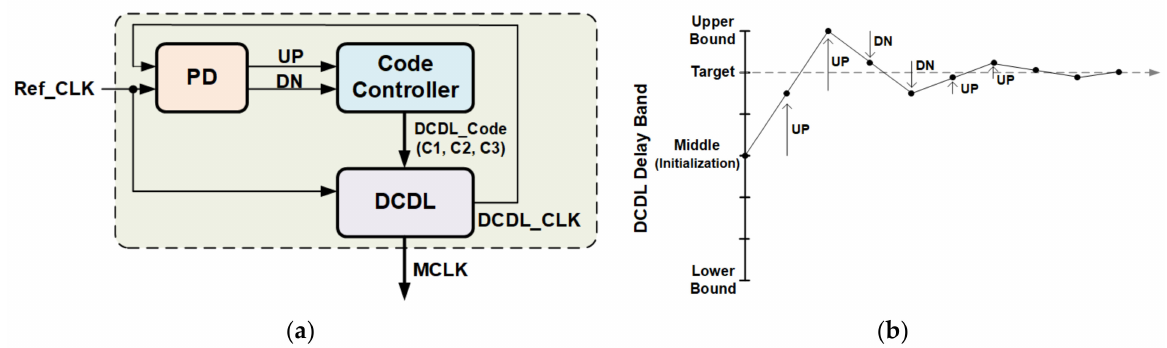
Figure 4. ( a ) The block diagram of ADDLL; ( b ) Binary search-locking